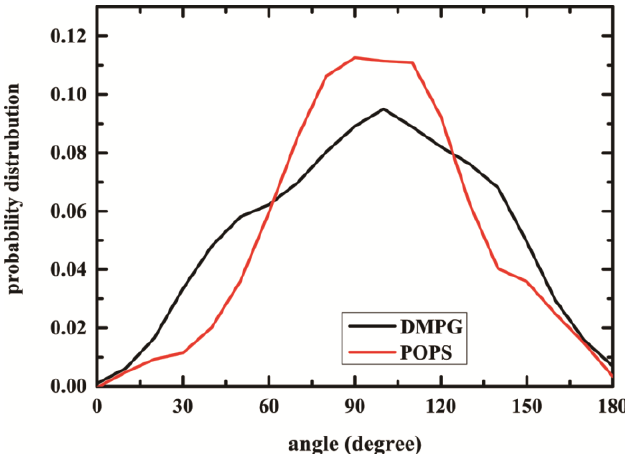
Figure 7. The order parameters for bilayer system averaged over the last 20 ns simulations. ( A ) The order parameters for DMPG bilayer system; ( B ) The order parameters for POPS bilayer system.